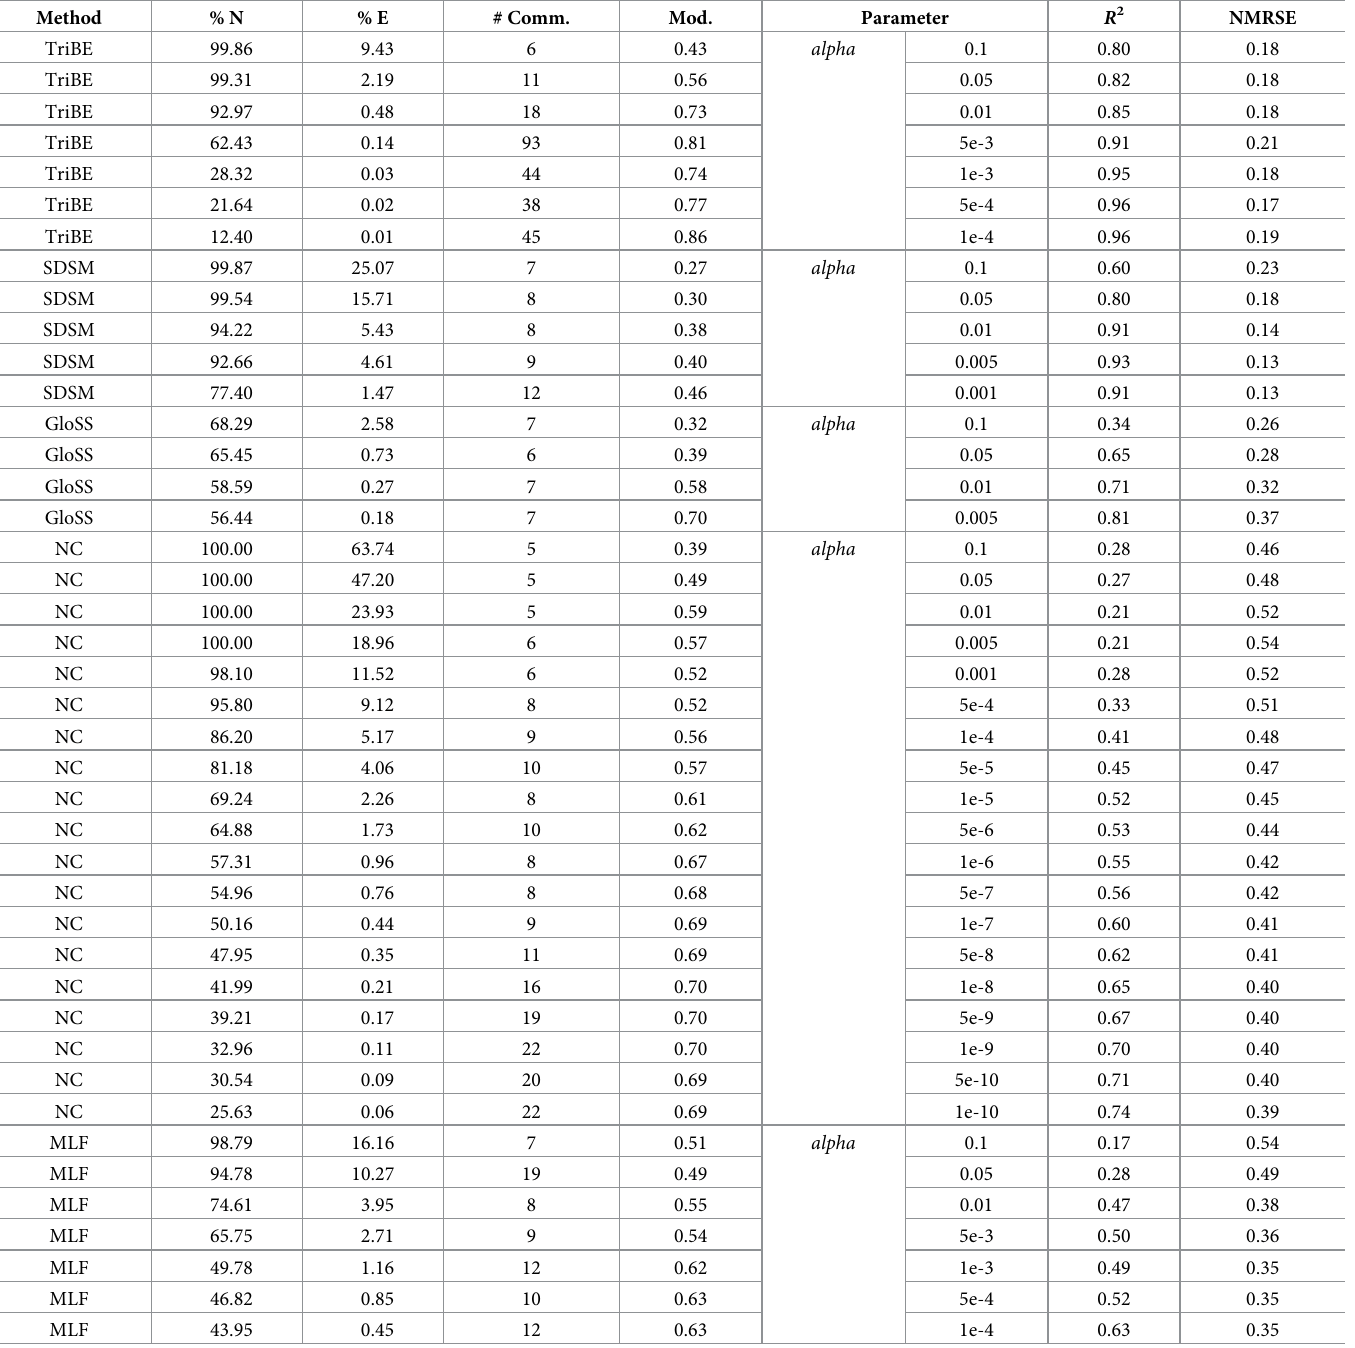
Table 6. Online discussions on Instagram: Impact of method parameters on topological and contextual